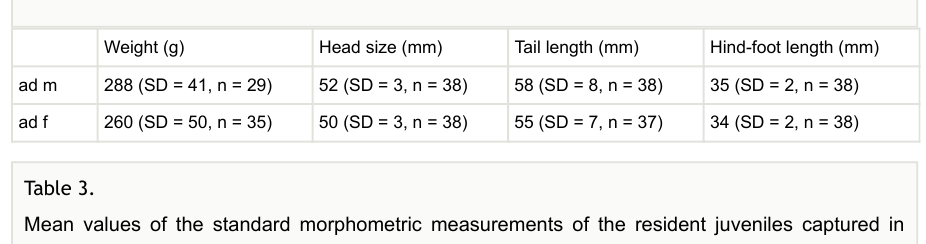
Mean values of the standard morphometric measurement of each sex-age group of the translocated adult ground squirrels in the period 2017-2019. n = sample size, SD = standard deviation.